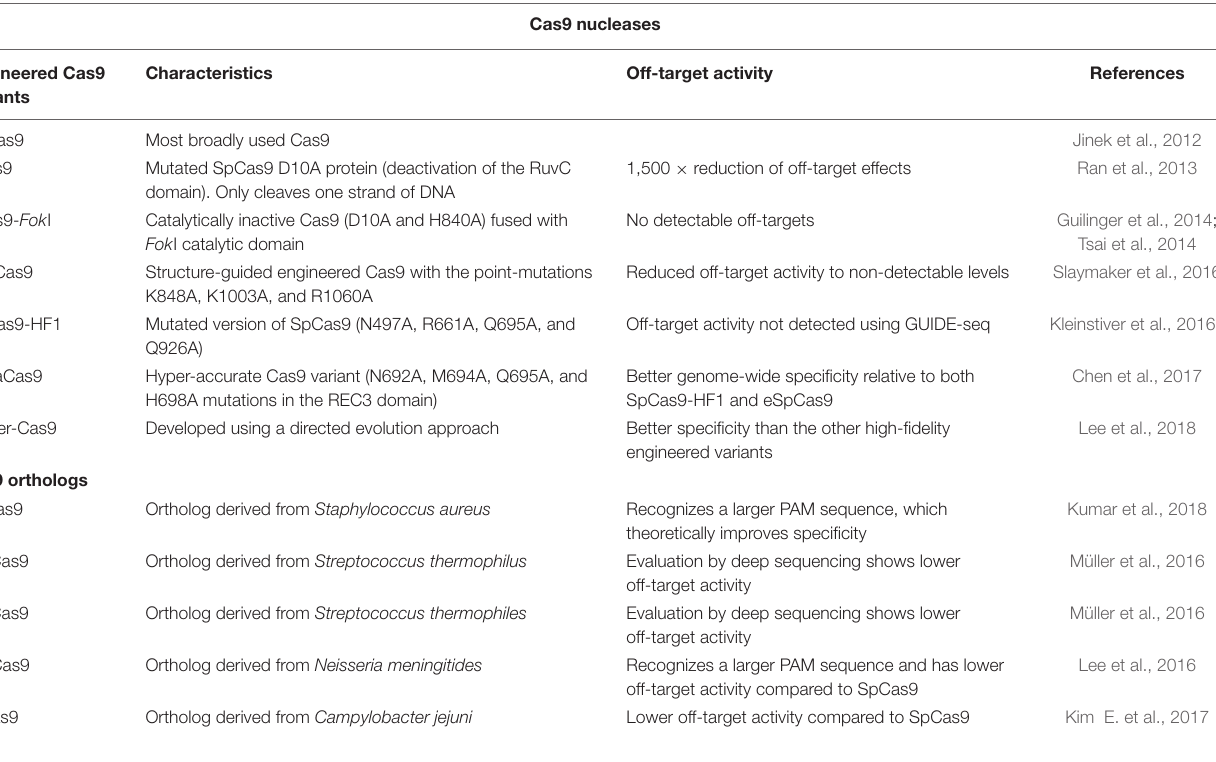
TABLE 2 | Summary table on the Cas9 nucleases currently available for CRISPR/Cas9-mediated gene